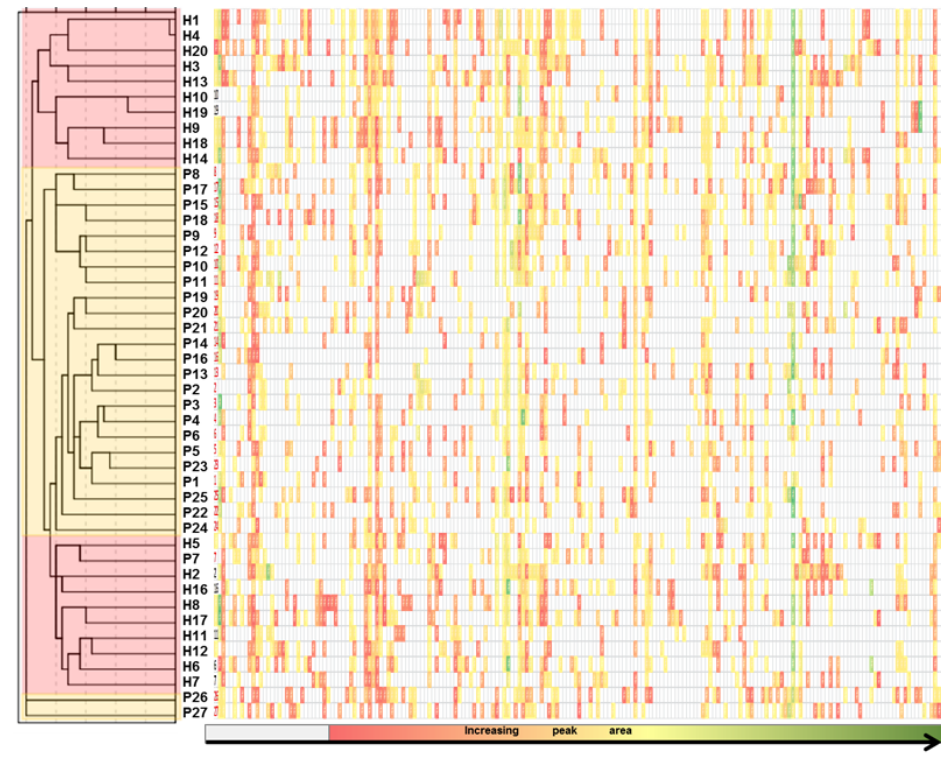
Figure 3. Heat map combined with dendrogram presenting hierarchical clusters segregation according with patient and control groups, where H 1to 20 represents the number of healthy control and P 1 to 27 the number of patients.